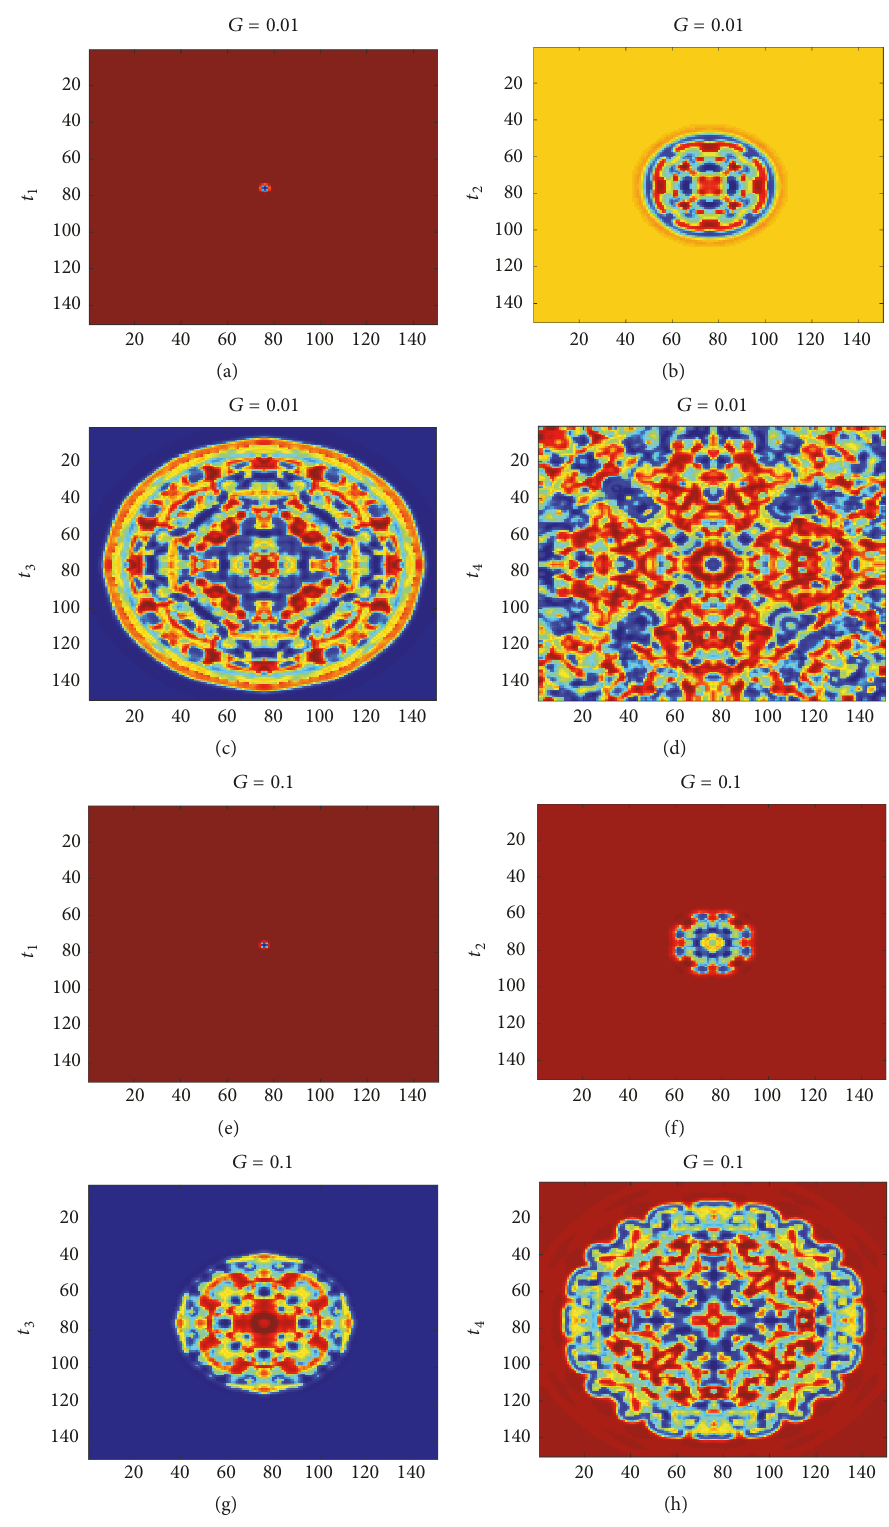
Figure 17: The snapshots of spatial distribution of membrane potential with color scale for neurons in the square array network for 𝑘 = 0.7 and 𝐷 = 1 at 𝑡 1 = 2 time units, 𝑡 2 = 75 time units, 𝑡 3 = 170 time units, and 𝑡 4 = 300 time units. ((a)–(d)) 𝐺 = 0.01 and ((e)–(h)) 𝐺 = 0.1